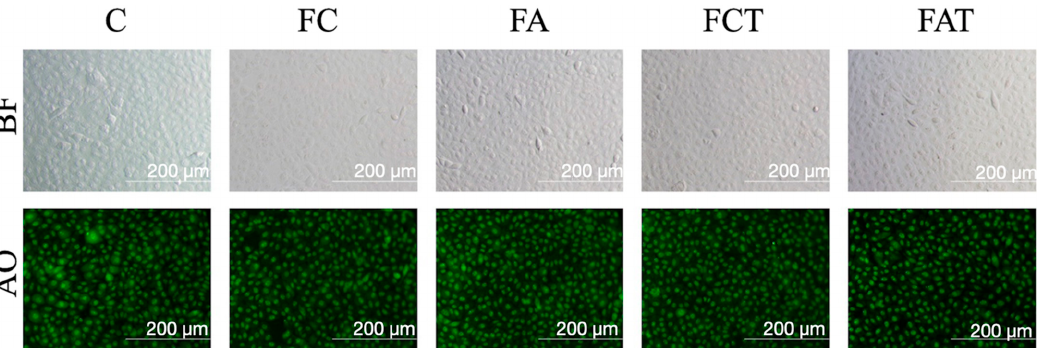
Figure 2. Bright field (BF) and acridine orange (AO) fluorescent images of L929 cell morphology after 24 h of incubation with eluates of materials. Cell morphology is similar to control, and green nucleus represents healthy cells. The images were captured multiple times and 20× magnification was used (IX70 Olympus, FITC, 460–490 nm fluorescent attachment, Tokyo, Japan). Materials 2022 , 15 , x FOR PEER REVIEW